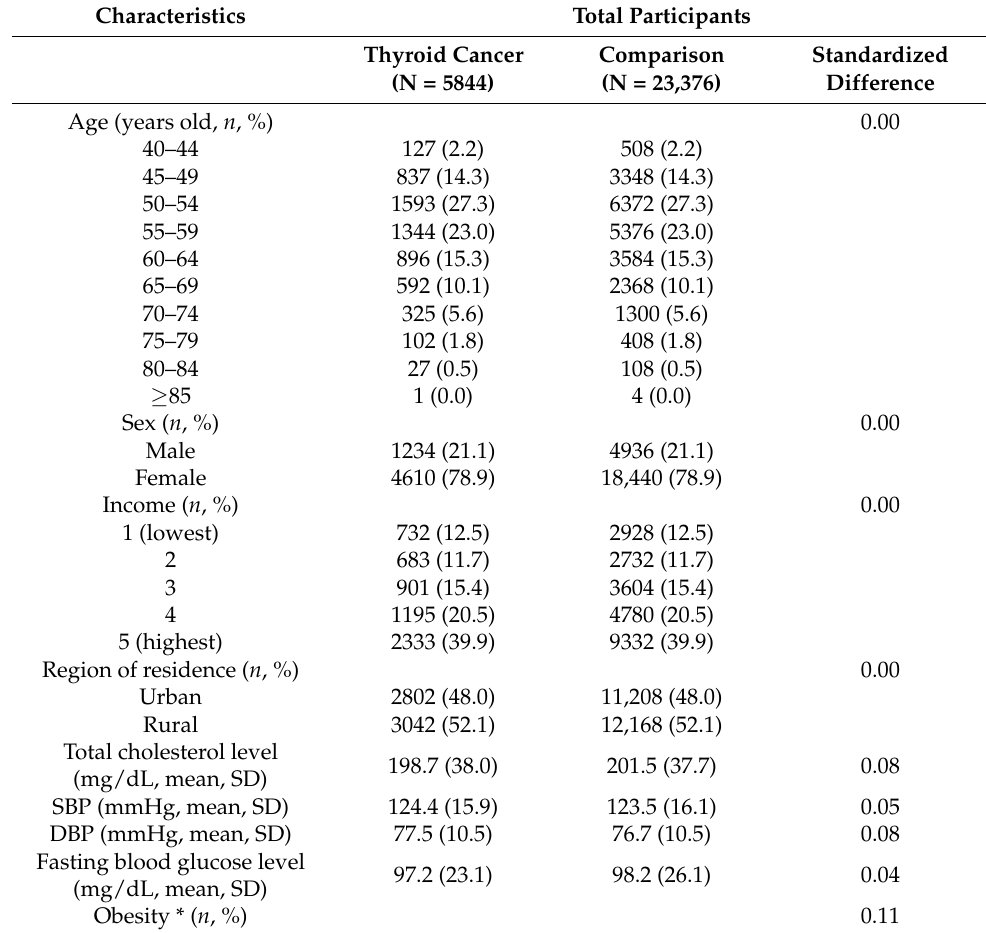
Table 1. General characteristics of